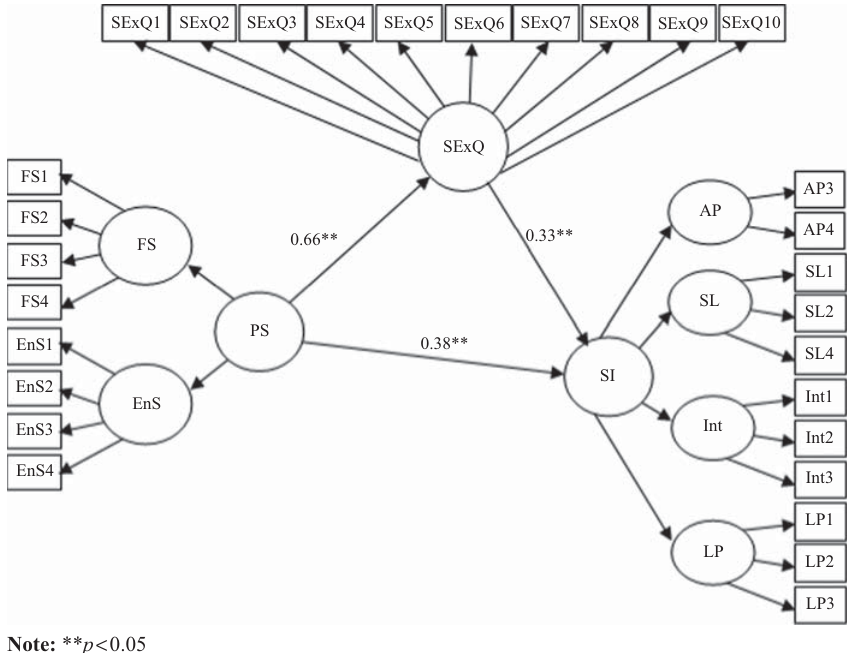
Figure 2. Structural model